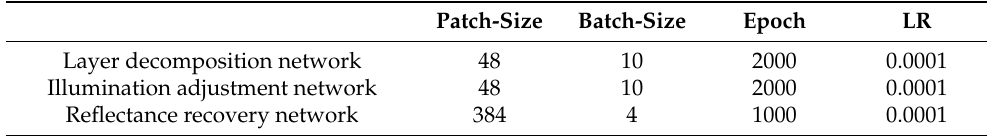
Table 1. KinD++ network training parameter setting.